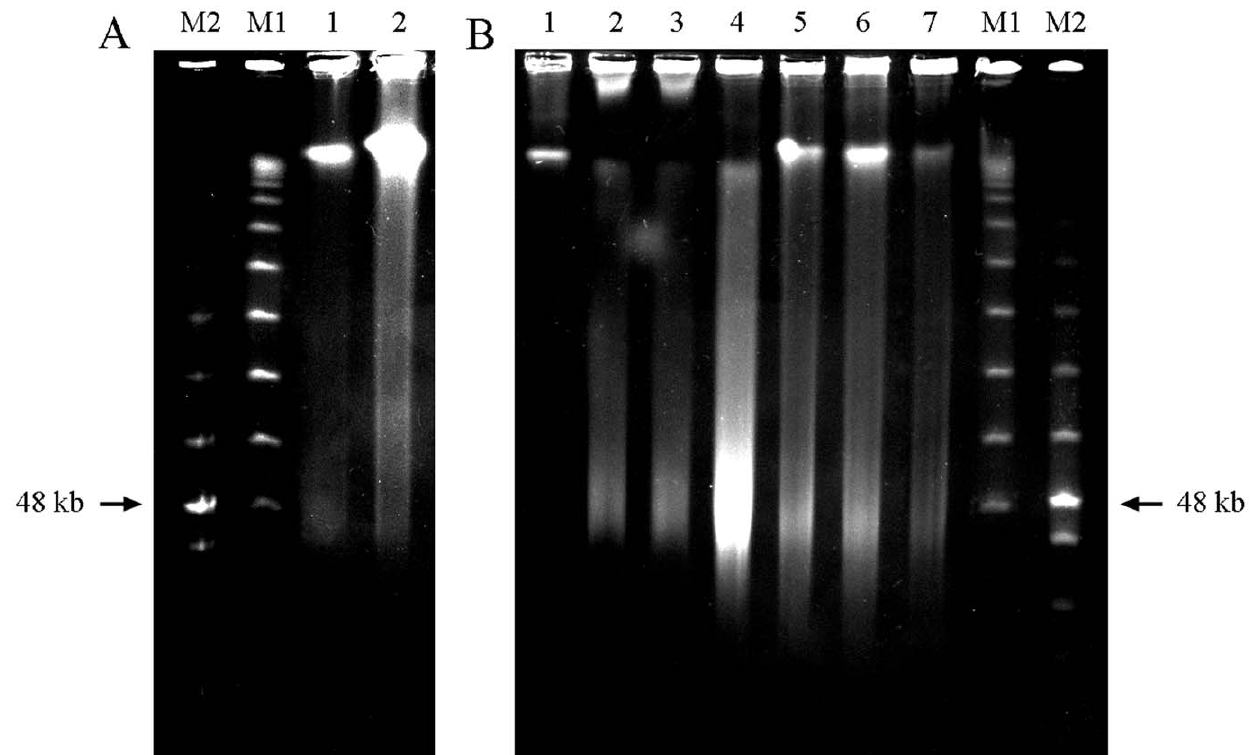
Figure 2. Pulsed-field gel electrophoresis of semen samples DNA from fertile donors (A, lanes 1 and 2; B, lane 1), negative control (B, lane 1), positive controls with DNAse 0.5 mg/ml, 30 minutes (B, lanes 2, 3 and 4) and RPL samples (B, lanes 5, 6 and 7). DNA molecular weight markers consisting of Low Range PFG Marker (M1) and Lambda ladder PFG marker (M2) are detailed. Negative controls in B, lane 1 show a thin compression zone. Positive controls in B, lanes 2, 3 and 4 show DNA digestion into sizes of around the 48 Kb. Sperm DNA fragmentation of the specific samples of this figure is shown in Table 2.